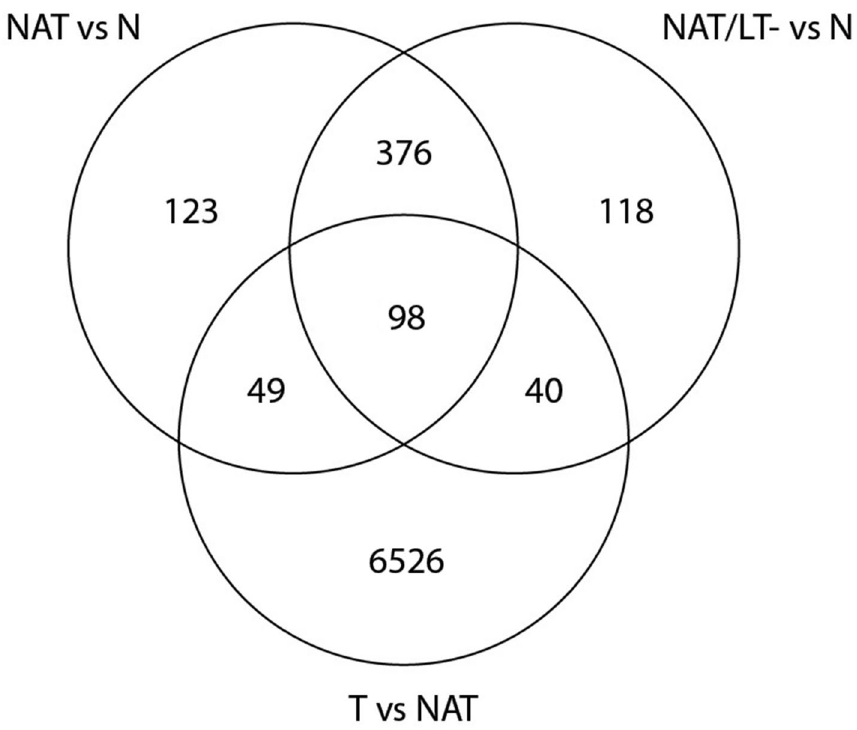
Figure 3. Venn diagram of differentially expressed genes (DEGs) among samples. Venn diagram to illustrate the overlapped DEGs between NAT vs N, NAT/LT− vs N, and T vs